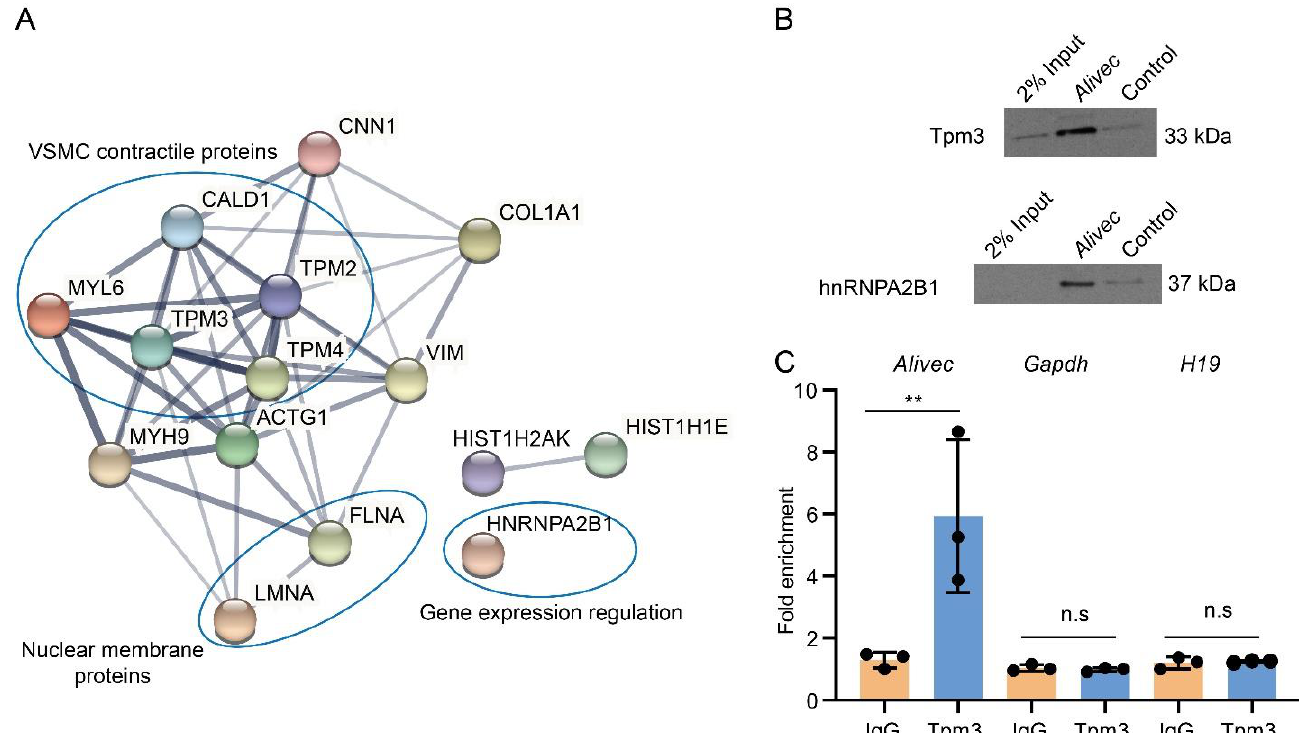
Figure 6. Alivec RNA interacts with hnRNPA2B1 and tropomyosin-3-alpha, a protein potentially associated with the contractile phenotype of VSMCs. ( A ) Network of protein complexes generated (using STRING database) from Alivec -specific interacting proteins identified by RNA-pulldown coupled to mass spectrometry. ( B ) Western blot analysis with Tpm3 antibody (upper panel) or hnRNPA2B1 antibody (lower panel) following RNA-pulldown assays with RVSMCs extracts using biotinylated Alivec RNA and poly A RNA as negative control (Control). ( C ) RNA immunoprecipitation assays with UV-cross-linked RVSMC cell extracts using anti-Tpm3 antibody and IgG as negative control. RNA from Tpm3 and IgG immunoprecipitates were analyzed by RT-qPCR, using indicated primers. Results were shown as fold enrichment over IgG. Data presented as mean ± SD, n = 3 biological replicates and ** p < 0.01 vs. IgG, using unpaired Student’s t -test. N.s. indicates not